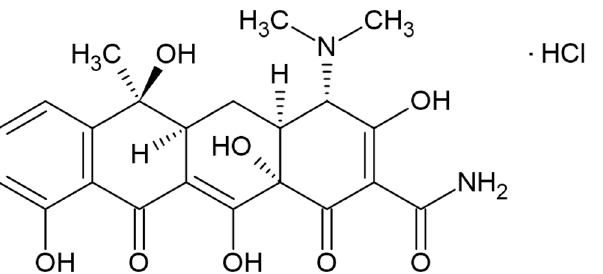
Figure 1. TC molecule used in the present study (drawn with ChemSketch Freeware software, version 2021.2.1, ACD/Labs, Toronto, ON, Canada [26]).